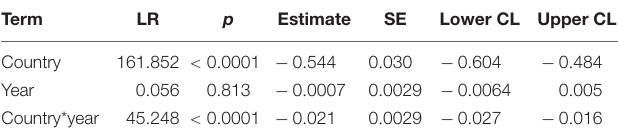
TABLE 2 | Generalized Linear Model (GLM) of number of insects in relation to country (Spain or Denmark), year (1997 or 2018) and country by year interaction in a model with normally distributed data and an identity link